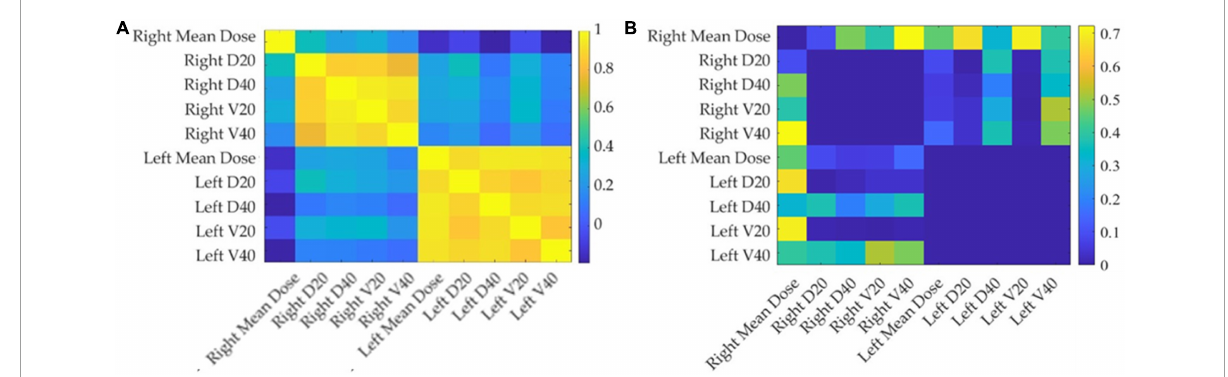
FIGURE3 Correlation and p -value matrix plot of DVH features. The left panel (A) depicts the Pearson’s coefficients among DVH features considered in this study, while the right panel (B) shows the corresponding p -values. The DVH-extracted parotid-related dose features considered in this study show strong positive correlations.